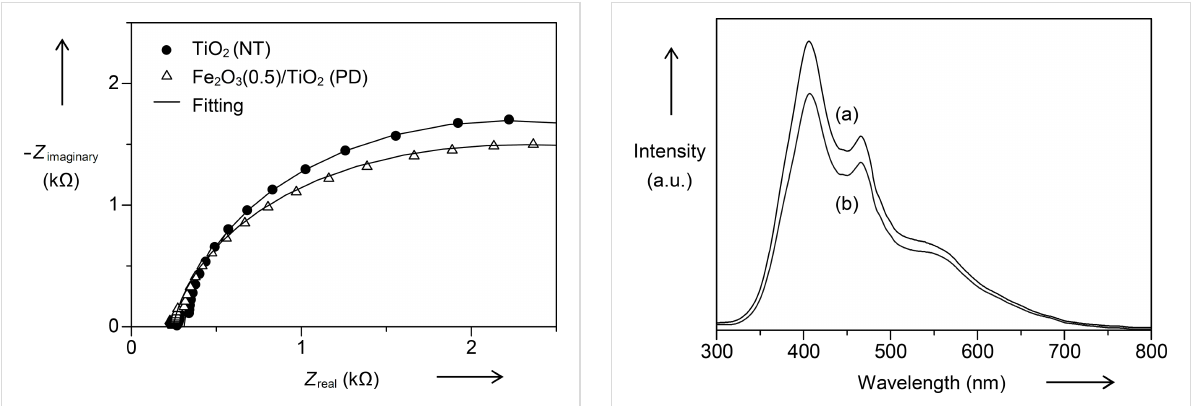
Figure 5: Nyquist plots of unmodified TiO 2 (NT) and Fe 2 O 3 (0.5)/TiO 2 (PD) with the respective model fitting.